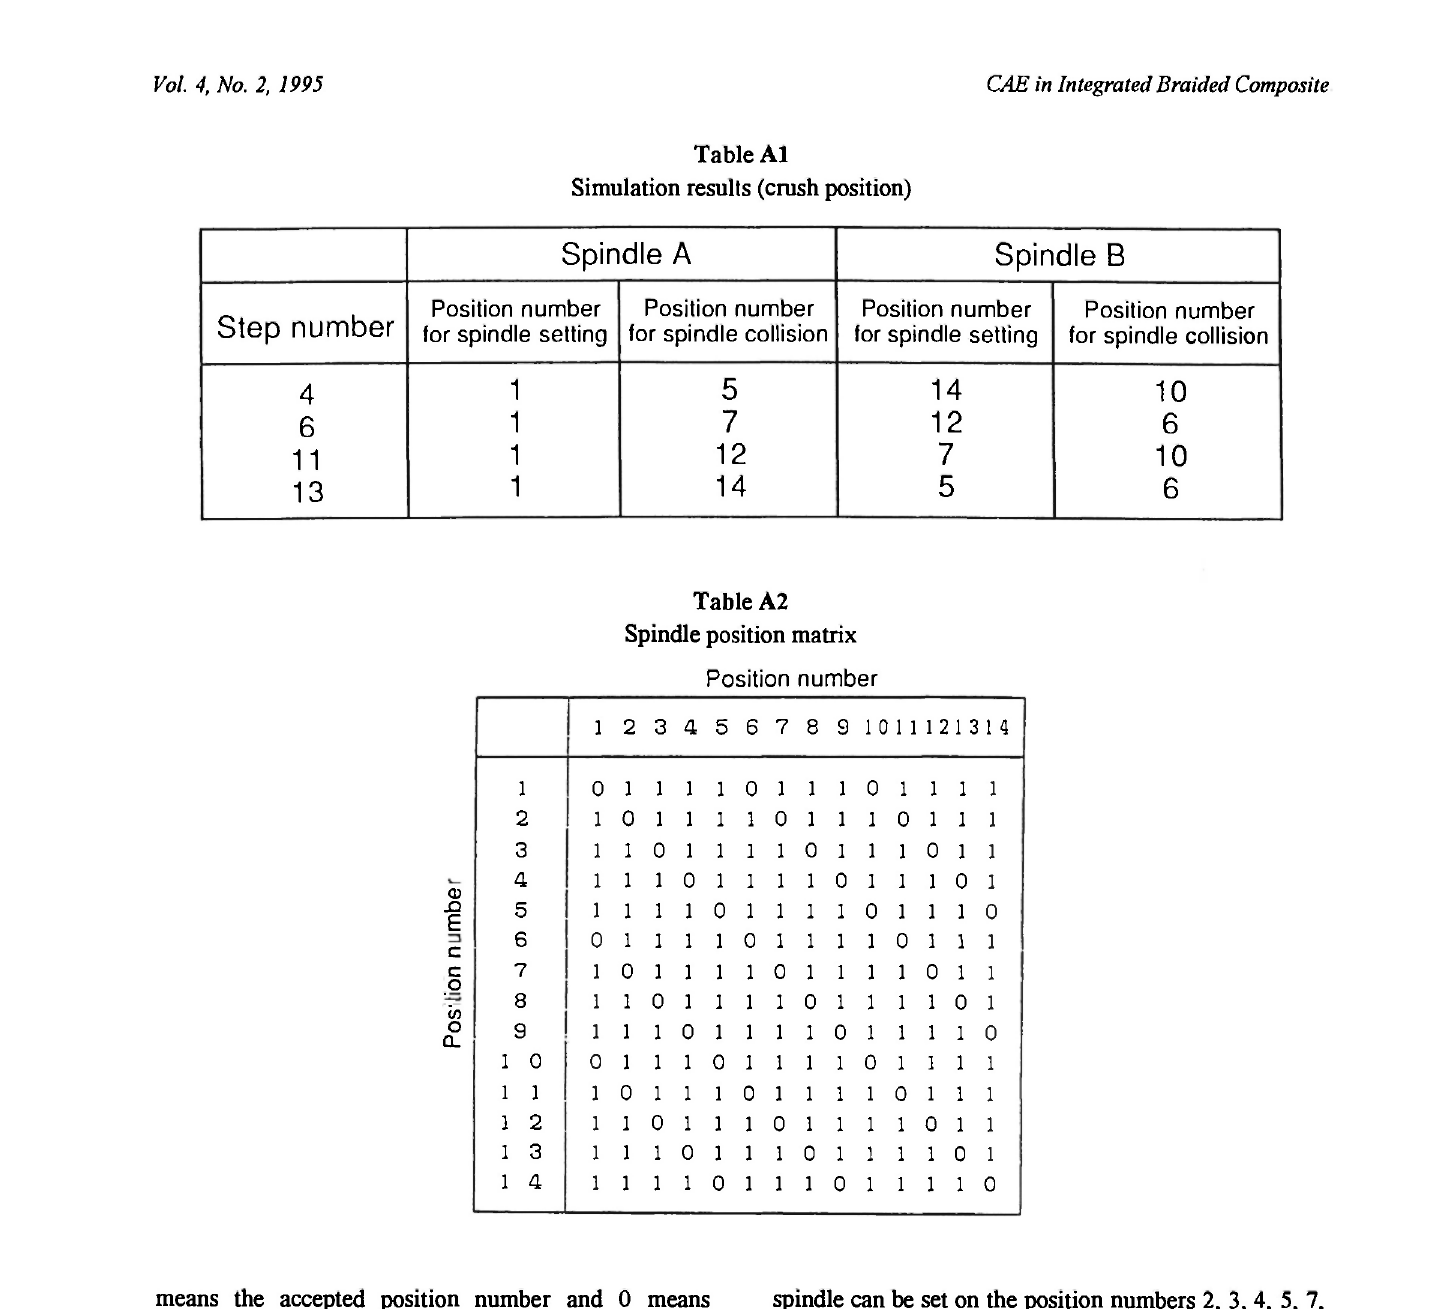
Spindle position